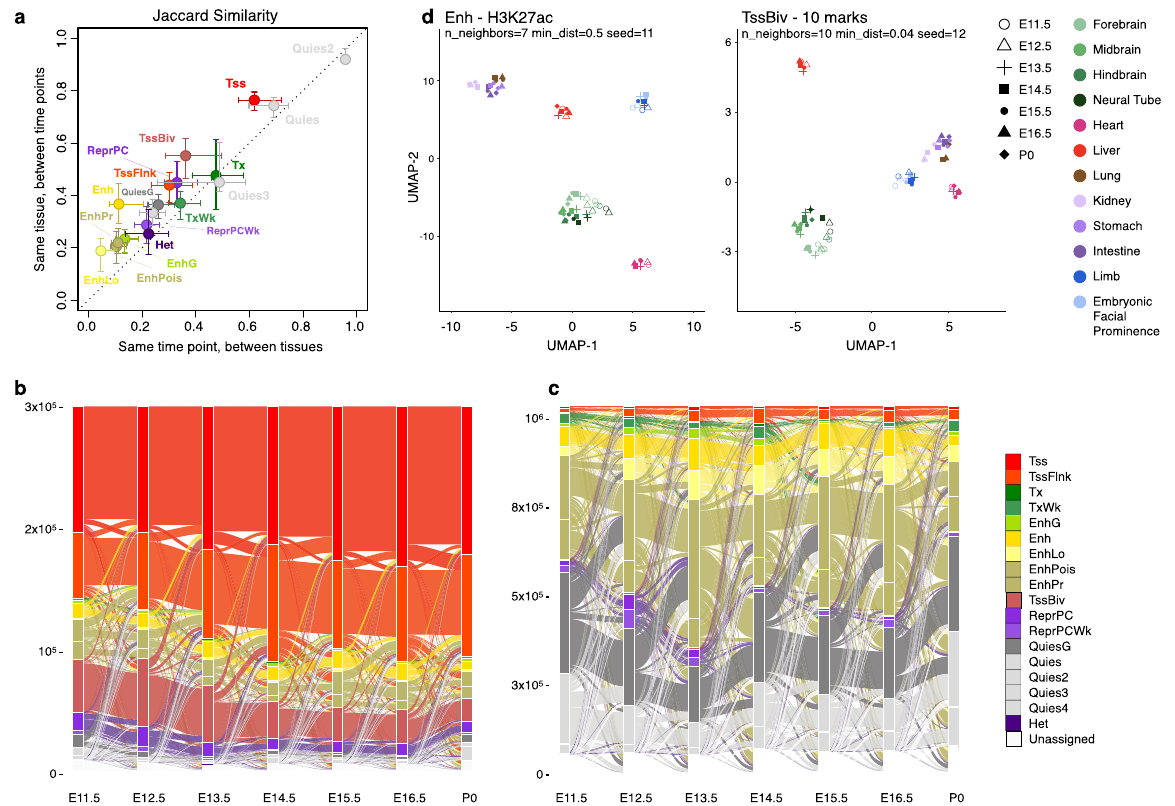
Fig. 2 Variations of the chromatin states across tissues and their transitions along the developmental trajectory. a Jaccard similarity between different timepoints in the same tissue ( y axis) versus the similarity between different tissues at the same timepoint ( x axis). Error bars indicate the range between the fi rst and third quartiles. b Transitions between chromatin states along midbrain developmental timepoints. For clarity, only the genomic bins assigned TSS-related states (Tss, TssFlnk, and TssBiv) at one or more timepoints are included. c Same as b but for genomic bins assigned enhancer-related states (Enh, EnhLo, EnhPois, and EnhPr) at one or more developmental timepoints. d Visualization of the 66 epigenomes in two dimensions using the UMAP technique. (Left) UMAP was given the H3K27ac signals in the Enh genomic bins across the 66 epigenomes. There were 735,048 such genomic bins, which were assigned Enh in one or more epigenomes. (Right) UMAP was given the signals of all 10 marks in the TssBiv genomic bins across the 66 epigenomes. There were 156,752 such genomic bins, which were assigned TssBiv in one or more